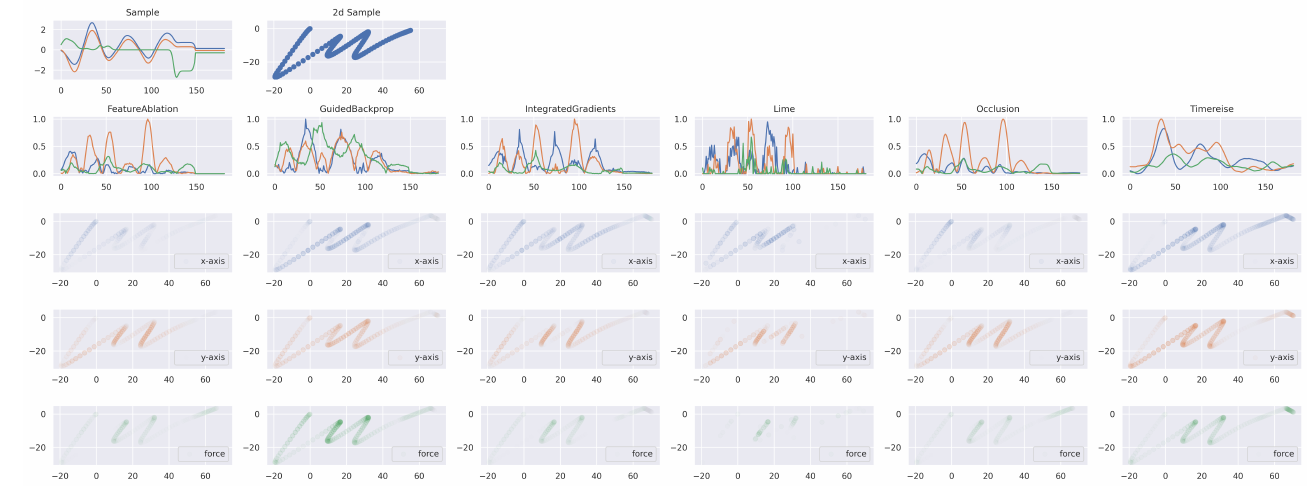
Figure 10. Attribution Maps. Shows the attribution maps for a single sample. The first row shows the original sample. The second row shows the actual attribution and the third row shows the histogram of the attribution scores within the given map. Generally, a large amount of low values in the histogram relates to a good separation between relevant and irrelevant features. ( a ) shows an anomalous sample in which the green peak corresponds to the anomalous signal part. Overall the attributions look similar except that TimeREISE is smoother compared to the other methods.